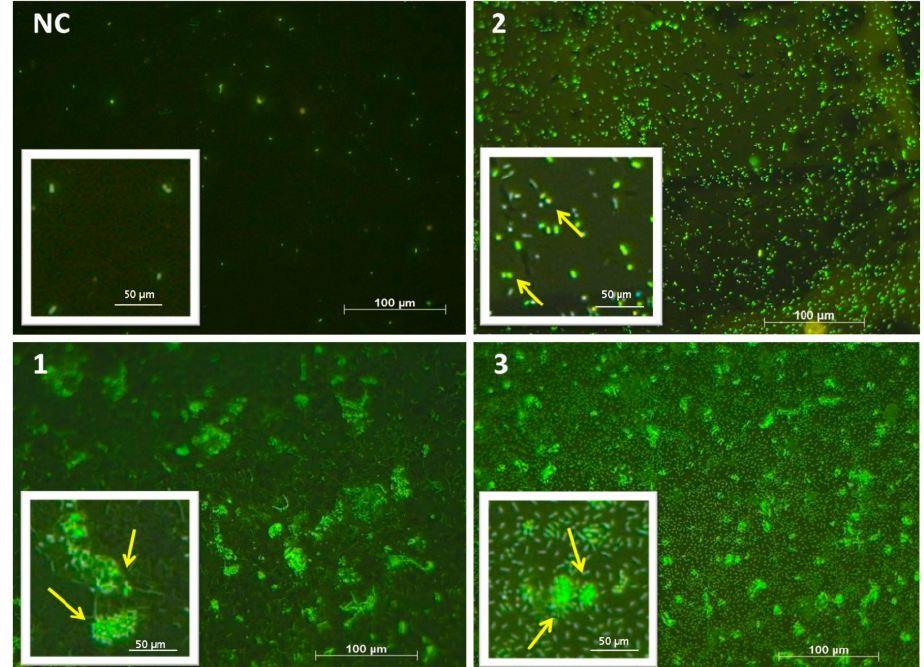
Figure 2. Fluorescent microscopy pictures of SYTO 9 stained C. marina biofilms formed after 1 h incubation on (NC) negative control, glass slide with staining procedure and without bacteria; and on glass samples with PEG-silane co-cross-linked coatings containing: (1) 6.0 wt % conventional cross-linker, ES 40 (control, bacteria and staining); (2) 4.0 wt % ES40 + 2.0 wt % PEG-silane; (bacteria and staining); (3) 6.0 wt % ES40 + 2.0 wt % PEG-silane, (bacteria and staining). The yellow arrows indicate areas with stained